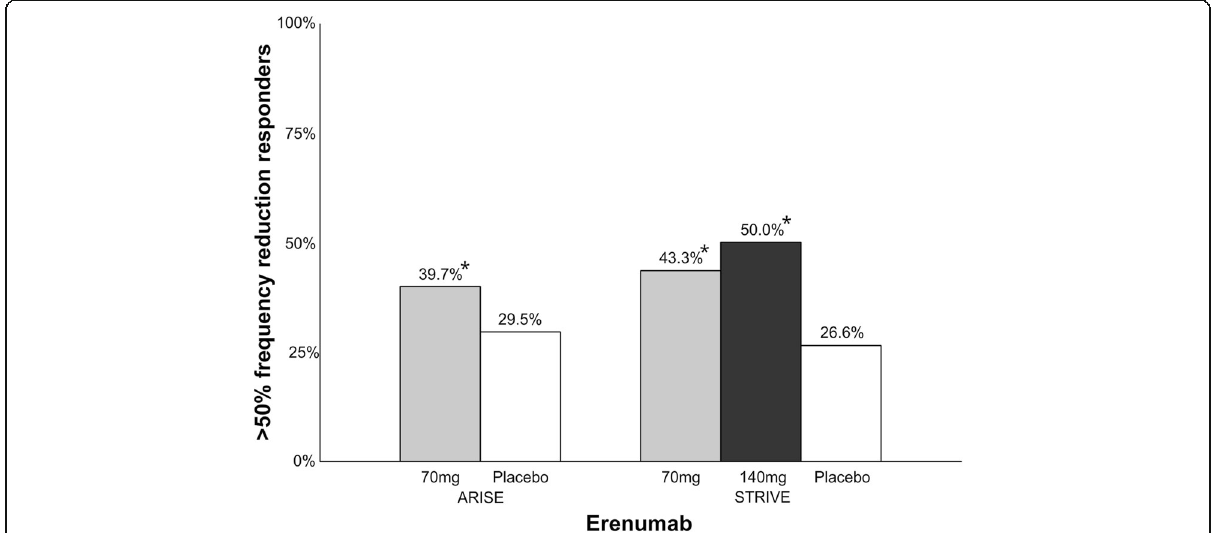
Fig. 7 Overview of patients (%) achieving > 50% reduction in migraine days in phase III clinical trials with erenumab. A darker bar indicates a higher dose. *ARISE; 70 mg vs. placebo, p = 0.010. STRIVE; 70 mg vs. placebo, p < 0.001; 140 mg vs. placebo, p <